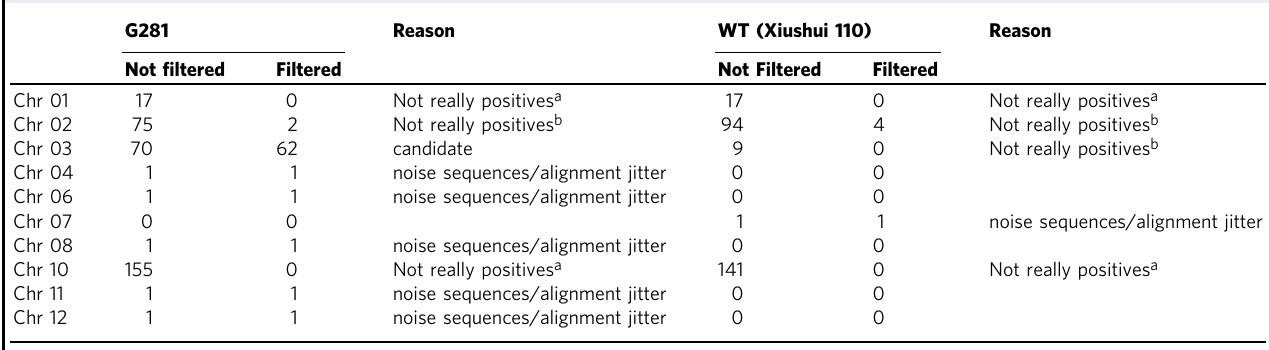
Table 2 Extracted read pairs crossing the transgene insertion site derived from original and modi fi ed TranSeq pipeline in G281 rice and WT.